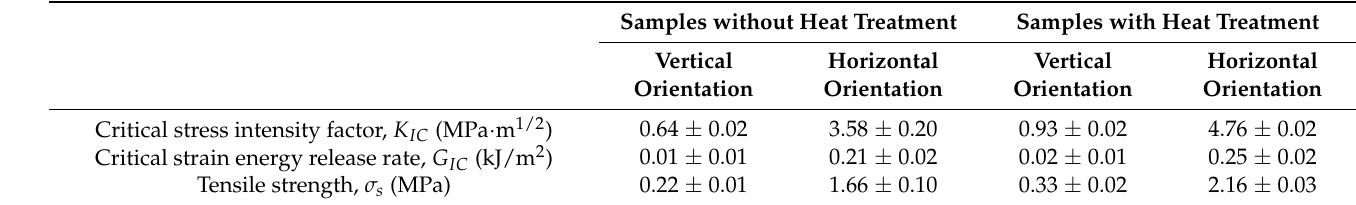
Figure 14. Results for stress intensity factor and critical strain energy release rate for samples with ( a ) and without ( b ) heat treatment. Table 6. Critical stress intensity factor, critical strain energy release rate and tensile strength ob- tained in CT tests. Samples without Heat Treatment Samples with Heat Treatment Vertical Orientation Horizontal Orientation Vertical Orientation Horizontal Orientation Critical stress intensity factor, 𝐾 (cid:3010)(cid:3030) ( 𝑀𝑃𝑎 ∙ 𝑚 (cid:2869)/(cid:2870) )